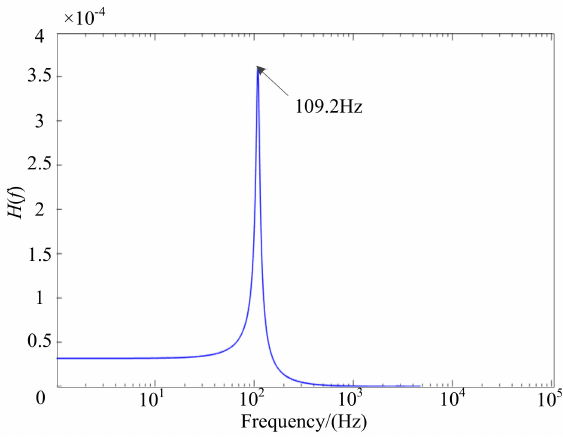
Figure 2. Viewgraph of the frequency response of the plastic